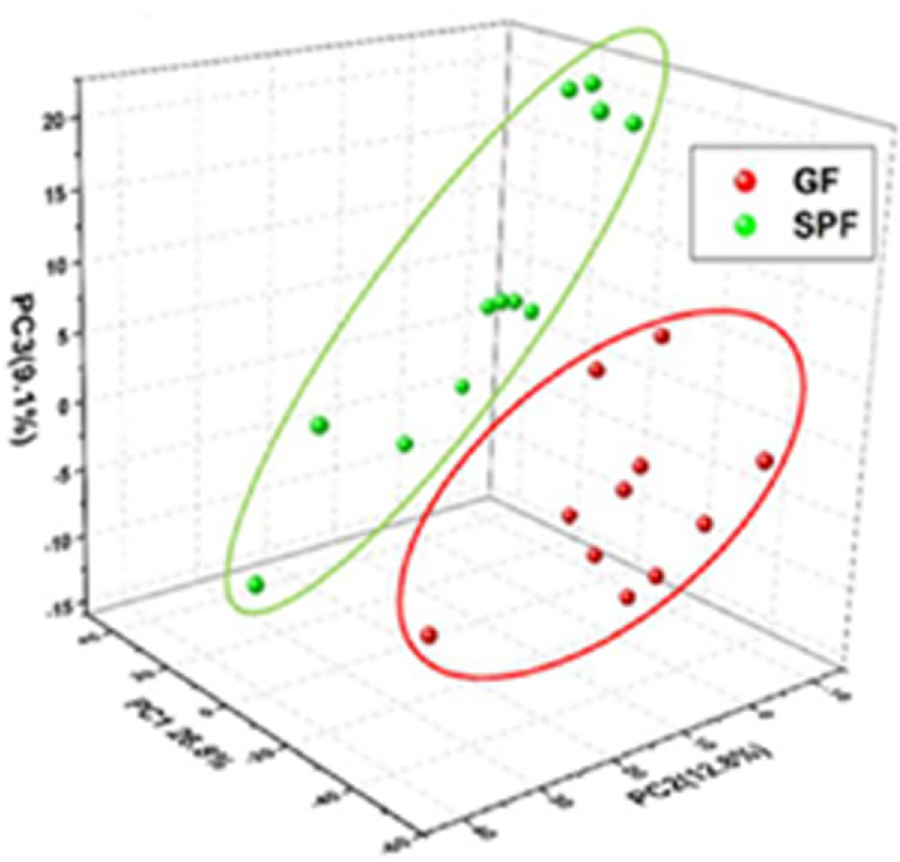
Fig 7. Three-dimensional principle component analysis (PCA) scores plot of serum samples in the ApoE -/- rats. There are obvious differences between germ-free (GF) serum samples and specific-pathogen-free (SPF) serum samples with PC1(26.8%), PC2(12.8%), and PC3(9.1%). Regardless of age, GF rats (n = 11) and SPF rats (n = 12) were separated from each other, indicating that the metabolome profiles were different.